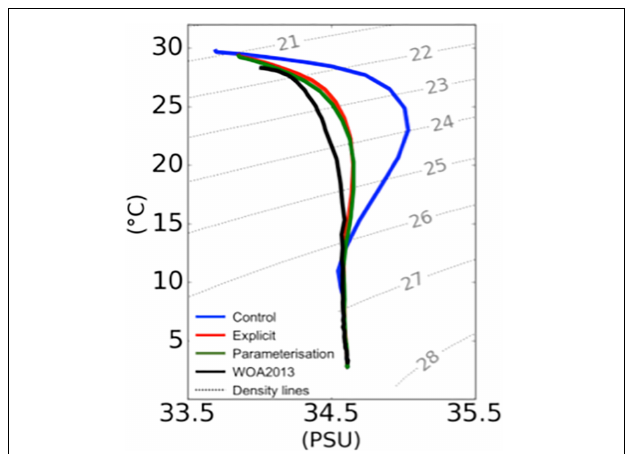
FIGURE 10 | Temperature-salinity diagram of averaged properties in the Banda Sea (124.75 ◦ E–130.83 ◦ E; 6.65 ◦ S–4.41 ◦ S) from the NEMO simulation that does not include tides (CTRL: blue line); the NEMO simulation that includes explicit tides (EXPL: red line); the NEMO simulation that parameterizes tides (PARAM; green line) and the WOA 2013 observed climatology (Figure from Nugroho et al., 2017. Permission obtained from